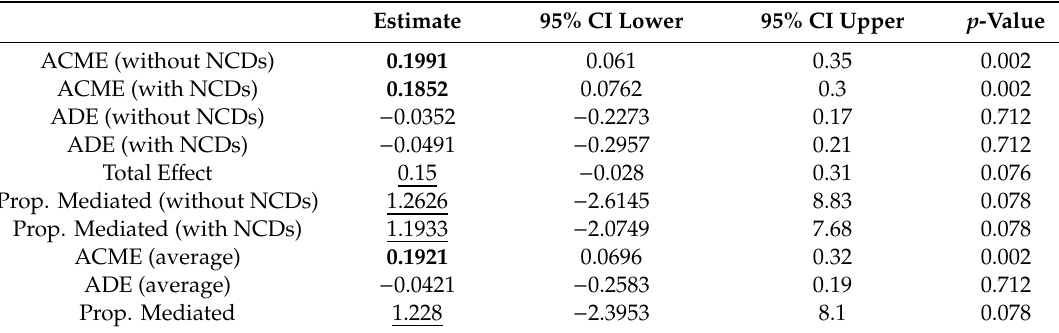
Table A3. Mediation results of all e ff